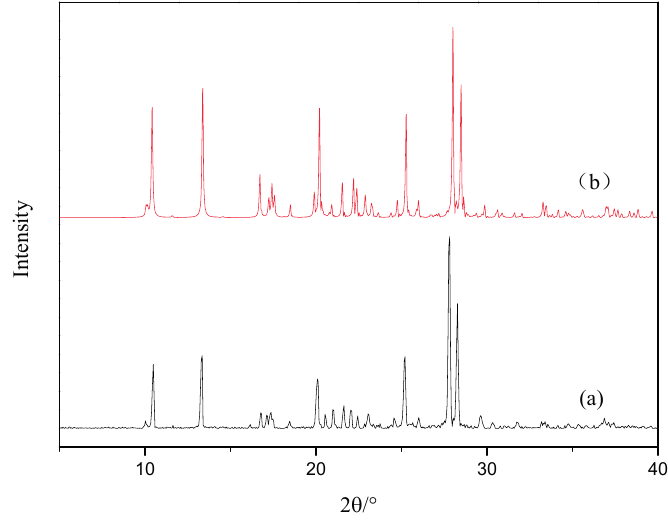
Figure 3. PXRD patterns of ( a ) cocrystal 1 and that ( b ) simulated from crystal